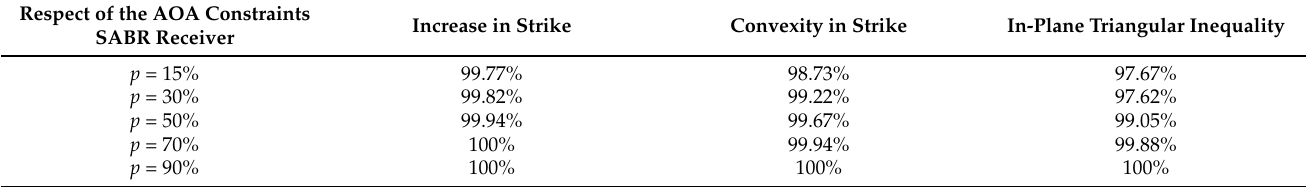
Table 5. Respect of the no-arbitrage constraints for the predicted OTM receiver swaptions priced by the SABR model with barycentric mean parameter interpolation, for increasing sizes of training